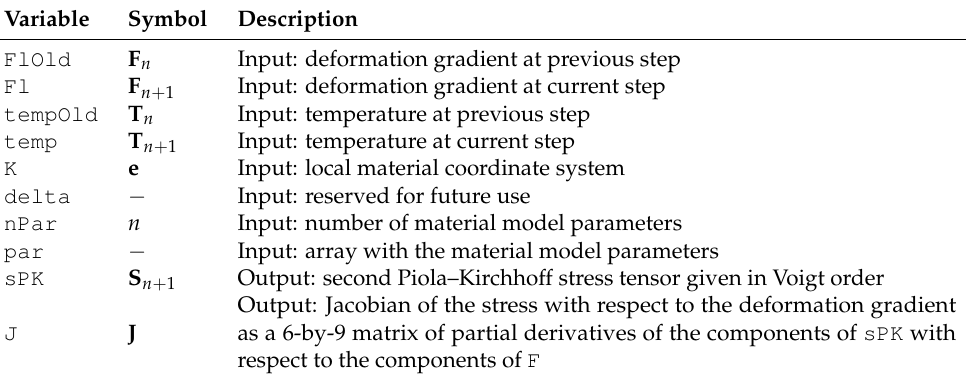
Table 3. List of input and output variables for a general stress deformation routine in COMSOL Multiphysics ® .